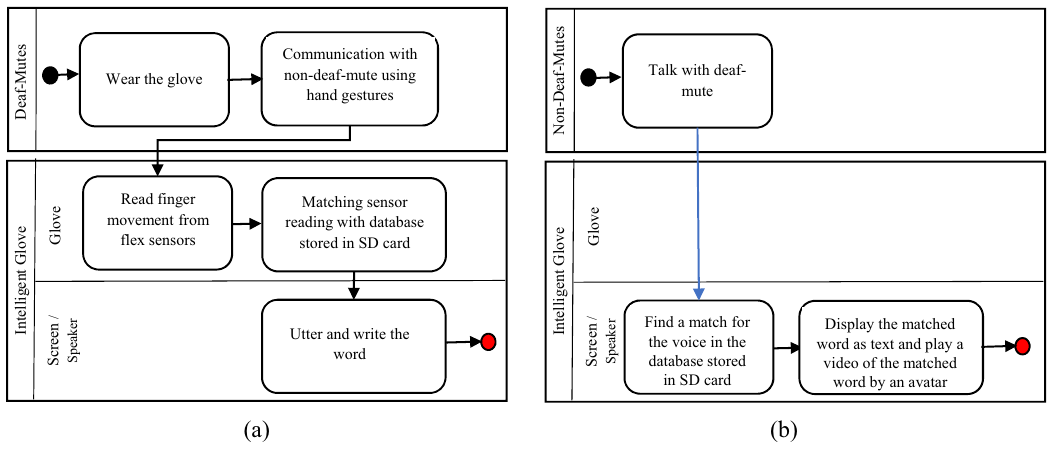
Figure 5: The BPMN diagram of ( a ) converting sign language to voice and text and ( b ) converting voice to sign language and